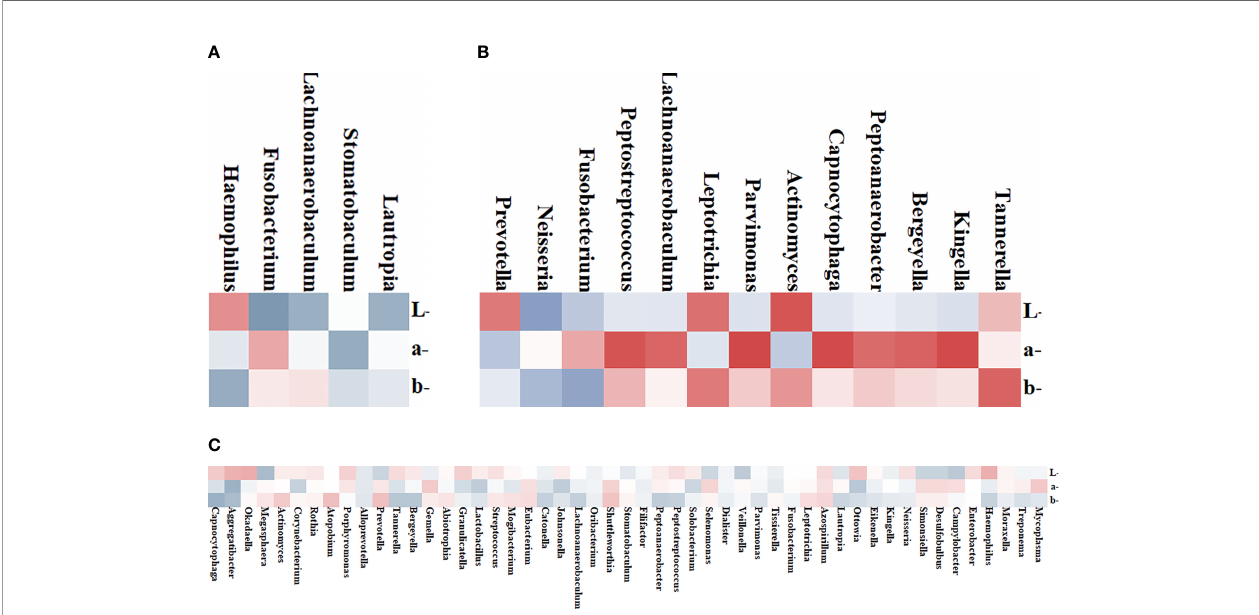
FIGURE 4 | Heat map of the correlation between tongue coating bacteria and the tongue image parameters. Red represents positive correlation and blue represents negative correlation; the darker the color, the stronger the correlation. (A) Four genera in the White Coating Group that were signi fi cantly related to L*a*b* values. (B) Thirteen genera in the Yellow Coating Group signi fi cantly related to L*a*b* values. (C) Tongue fl ora in both groups signi fi cantly related to L*a*b* ( a*/b* values, R = 0.434/0.374 , Figure 4C ), Okadaella ( L* values, R = 0.327 , Figure 4C ), and Megasphaera ( L* values, R = 0.378 , Figure 4C ) were signi fi cantly correlated with tongue image parameters.